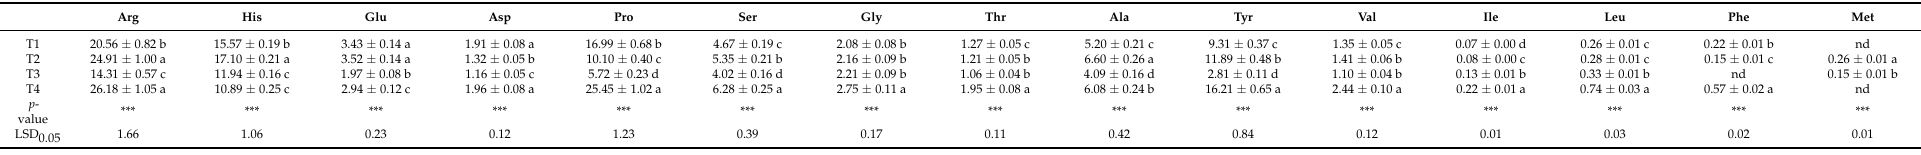
Values are means ± standard deviation ( n = 9). Values with different letters indicate significant differences among treatments. The level of significance was represented as p < 0.001